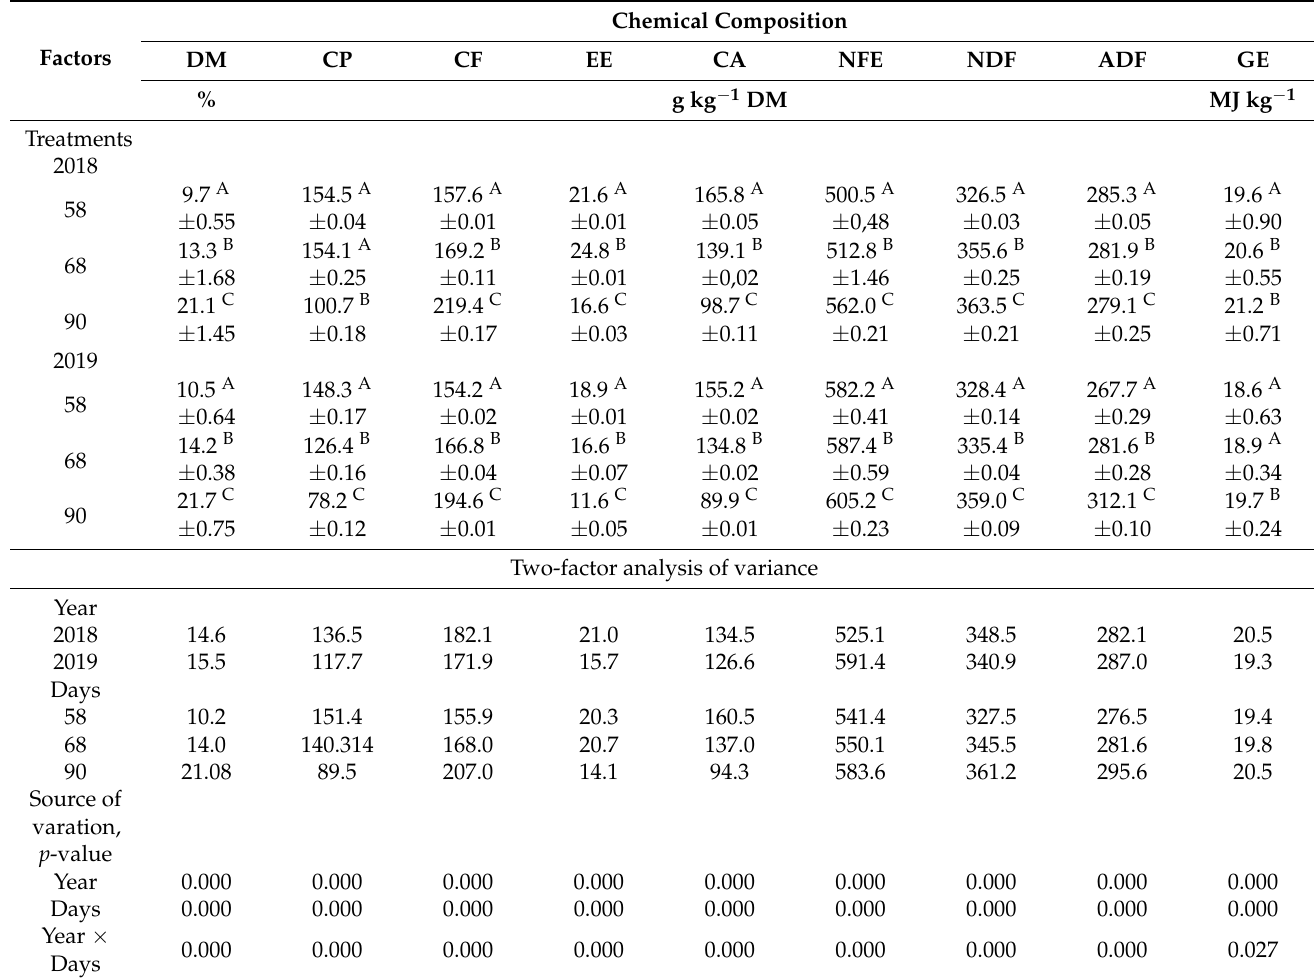
Table 3. Effect of harvesting date on chemical composition of green fodder ( n = 10).